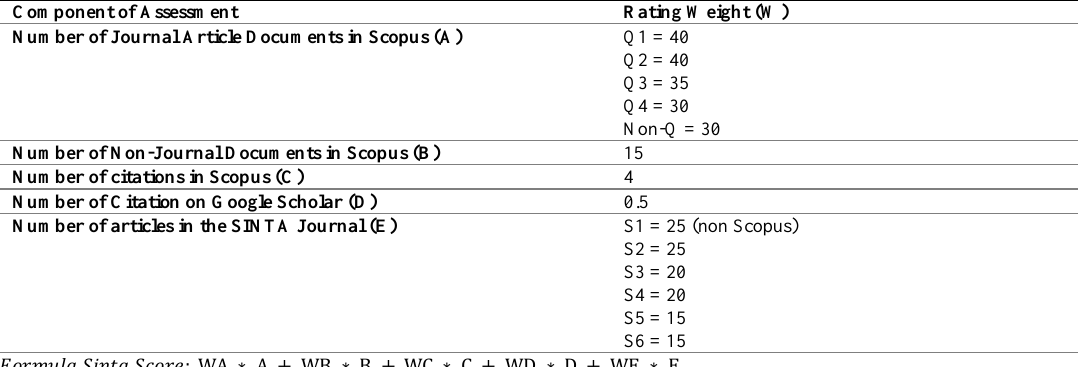
Table 3 : SINTA Score Component and Formula version 2